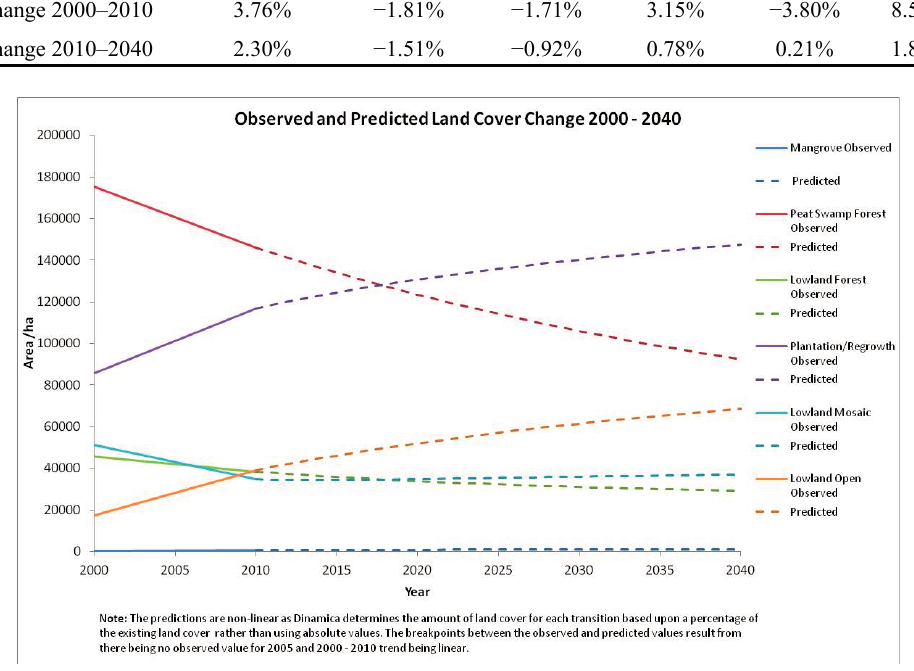
Figure 2. Observed and Projected Land Cover Change